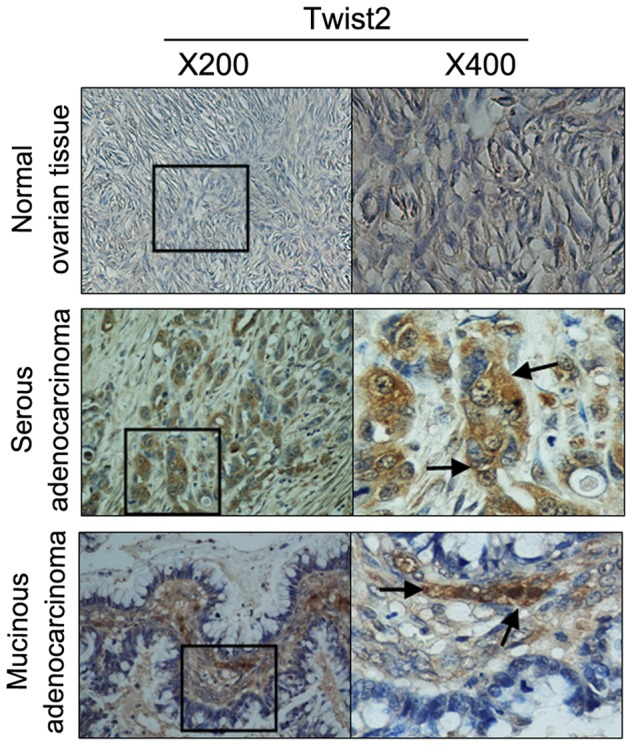
Immunohistochemical (IHC) staining of Twist2 expression on paraffin-embedded ovarian carcinomas tissue array sections.Tissue sections of ovarian carcinomas and normal ovaries were analyzed by IHC staining with a specific monoclonal antibody against human Twist2. The positive staining of Twist2 was shown in brown color. The sections were counterstained with hemotoxylin to show nuclei. Representative images of Twist2 staining in paired normal ovary and epithelial ovarian carcinomas are shown. No expression of Twist2 could been seen in normal adult ovary tissues, while positive expressions of Twist2 were mainly localized in cytoplasm or nucleus of the serous adenocarcinoma and the mucinous adenocarcinoma ovarian tumor cells. Magnitude ×200, ×400.